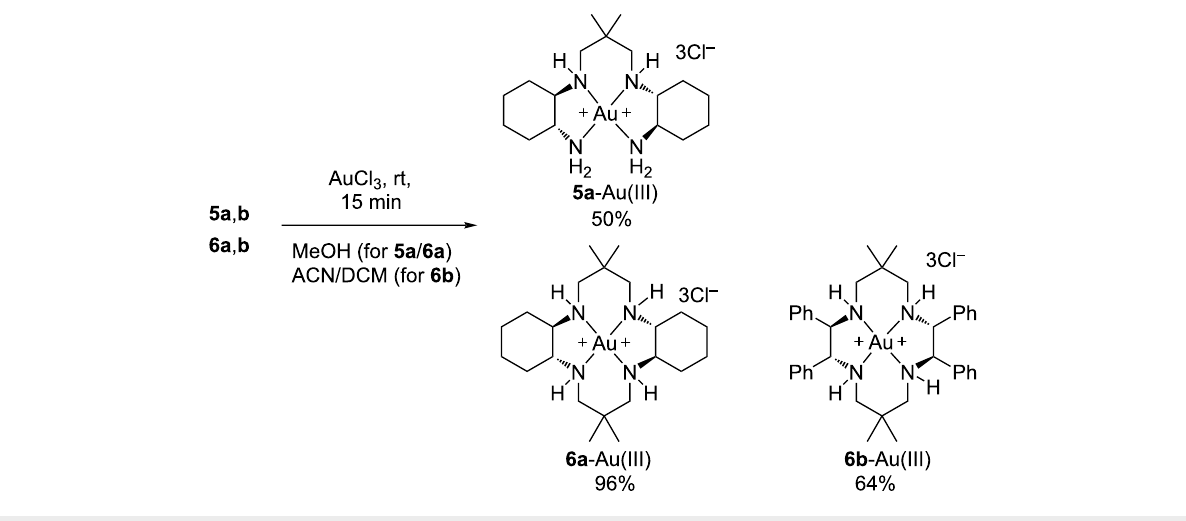
solubility of cyclam 6b , allowing formation of 6b -Au(III) in 64% yield (Scheme 3). The corresponding Δδ 1 H coord values of 6b -Au(III) were similar to those discussed for 6a -Au(III). Sur- prisingly, tetraamine 5b did not behave in a similar way as the other ligands, instead giving a complex mixture, as judged by 1 H NMR, when attempted coordinated to Au(III). Changing the source of Au(III) or the solvents methanol, acetonitrile and